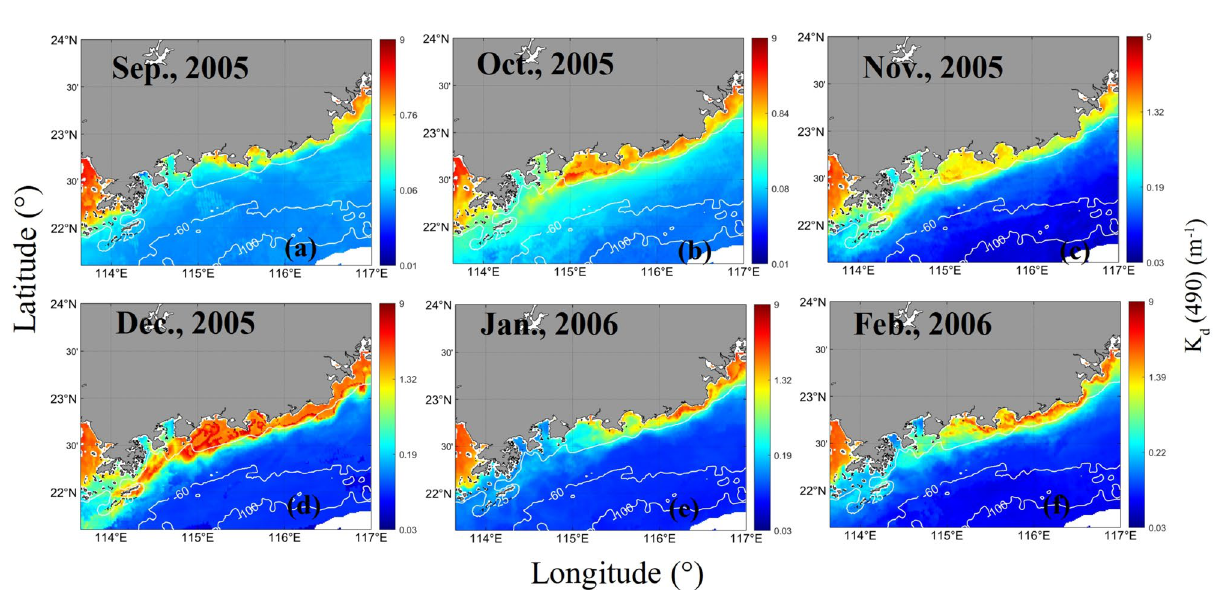
Figure 10. The monthly mean K d (490) values (m −1 ) from September 2005 to February 2006. The program